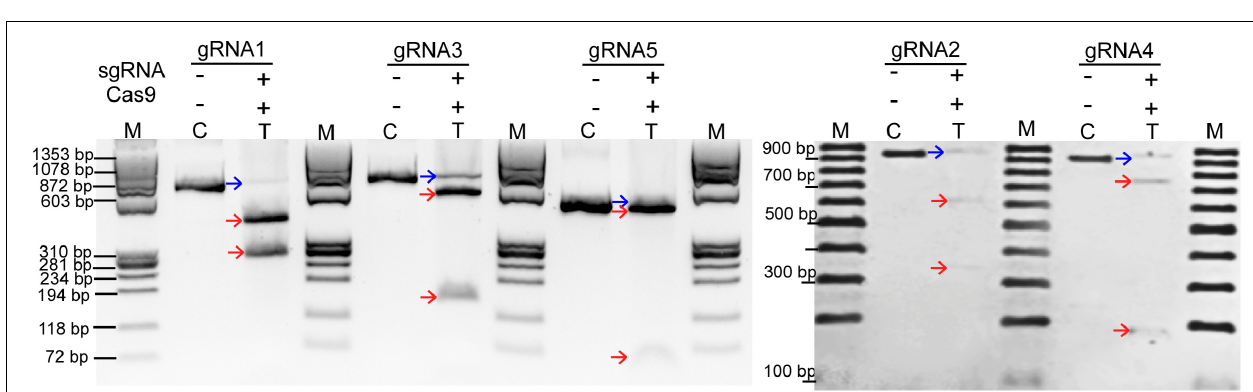
FIGURE 5 | In vitro cleavage assay. The in vitro transcribed or purchased sgRNAs at GmCPR5 loci were mixed with SpCas9 and PCR templates of target sites (gRNA1–5) for in vitro digestion and resolved on 2% agarose gel. Lanes M, DNA ladders; C, PCR wild type (control untreated); T, treated with sgRNAs and SpCas9. The parental and cleaved fragments are indicated with blue and red arrows,